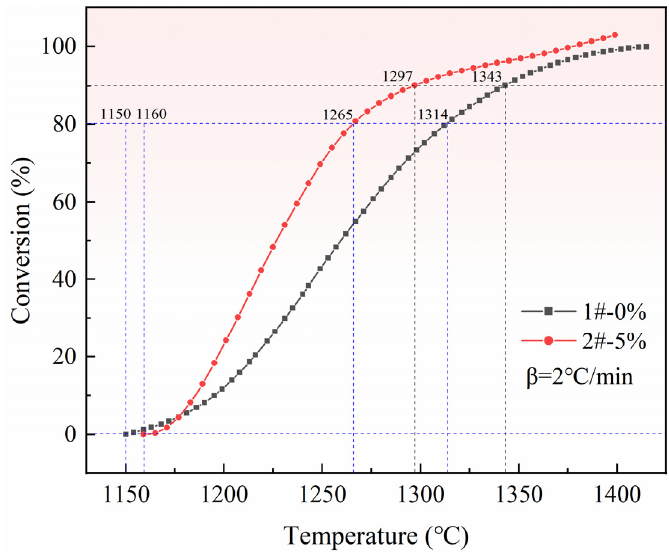
Figure 12. Comparison of reduction conversion between two pellets.